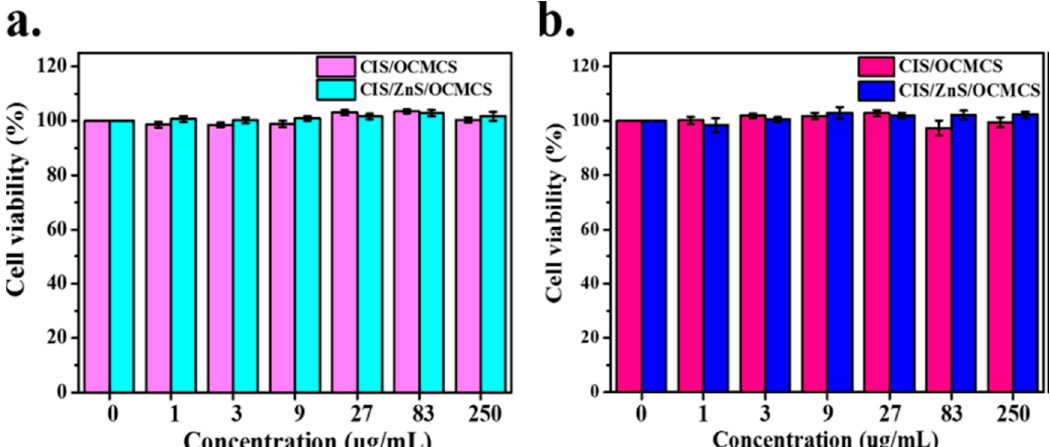
Figure 15. In vitro cell viability test of ( a ) Hela and ( b ) Human Oral Squamous Carcinoma Cell Line (OECM) incubated with different concentrations (1, 3, 9, 27, 83, and 250 μ g/mL) of CIS/OCMCS (O-